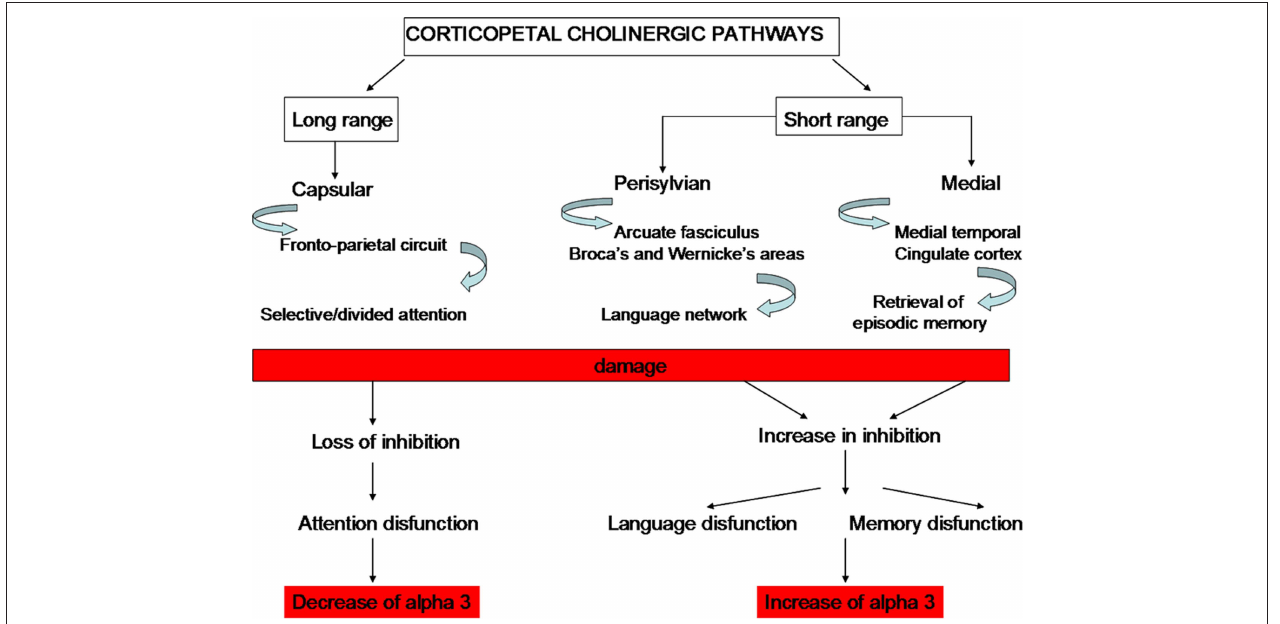
FiGurE 6 | Theoretical, neurophysiological and clinical effects of damage to the cholinergic pathways (see Moretti et al., 2008b).